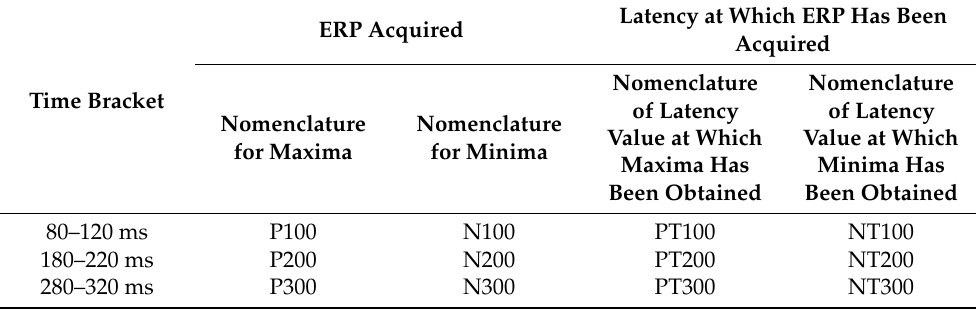
Table 2. The ERP features acquired from EEG signals and their nomenclature.